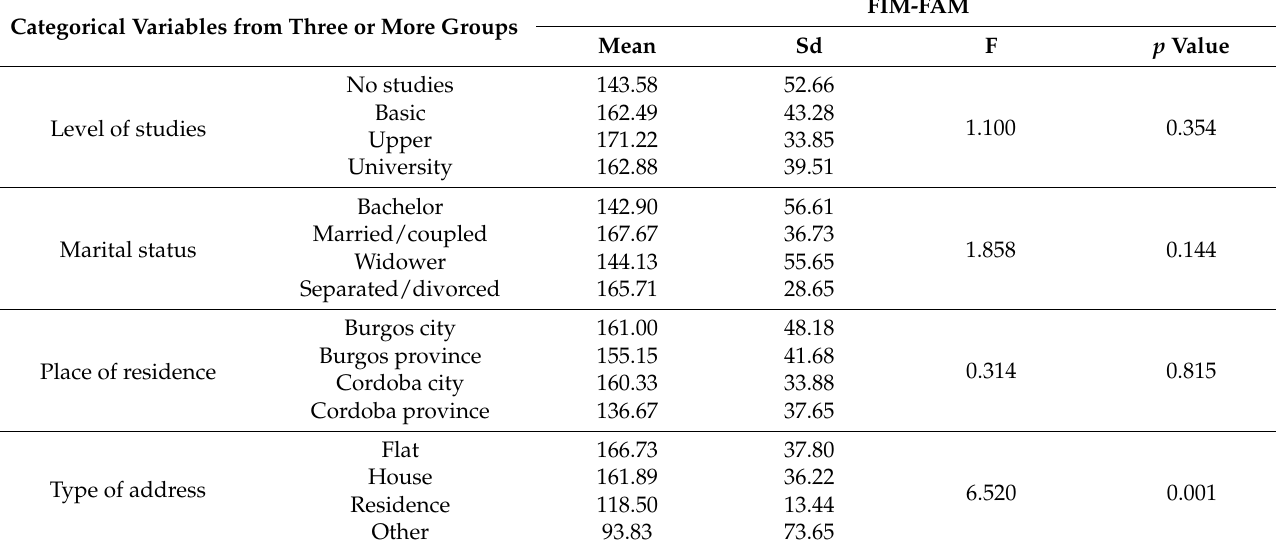
Table 3. Differences between independent study variables of three or more groups in functional independence using ANOVA.